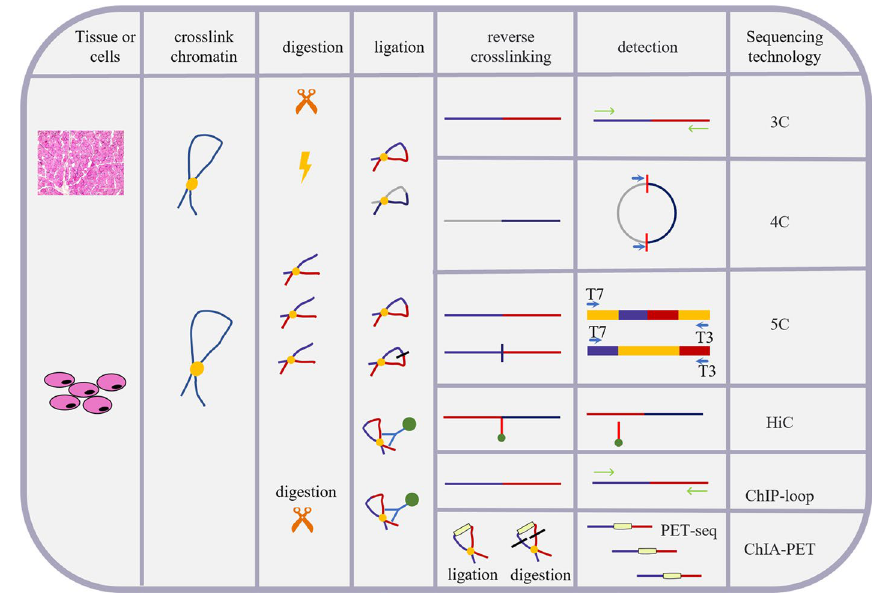
Fig. 1 Overview of chromosome conformation capture technology (3C) and 3C-based technology. Formaldehyde fixation is cross-linked, followed by digestion and ligation with specific